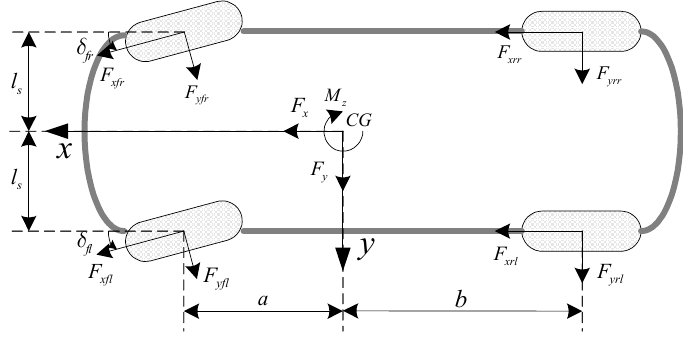
Figure 3. Coordinates for planar motions of the